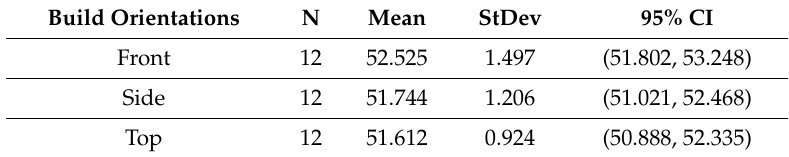
Table 19. Mean, standard deviation, and confidence interval for UTS as a function of build orientations.